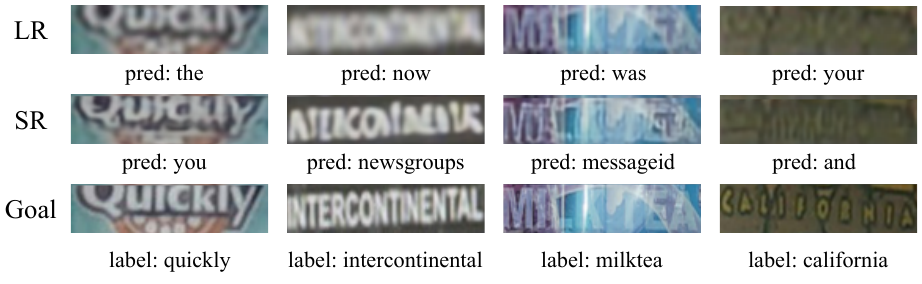
Figure 8. Examples of failures of images generated using MTSR. Several factors, such as complex backgrounds, unique fonts, and close spacing of characters, can limit text restoration using